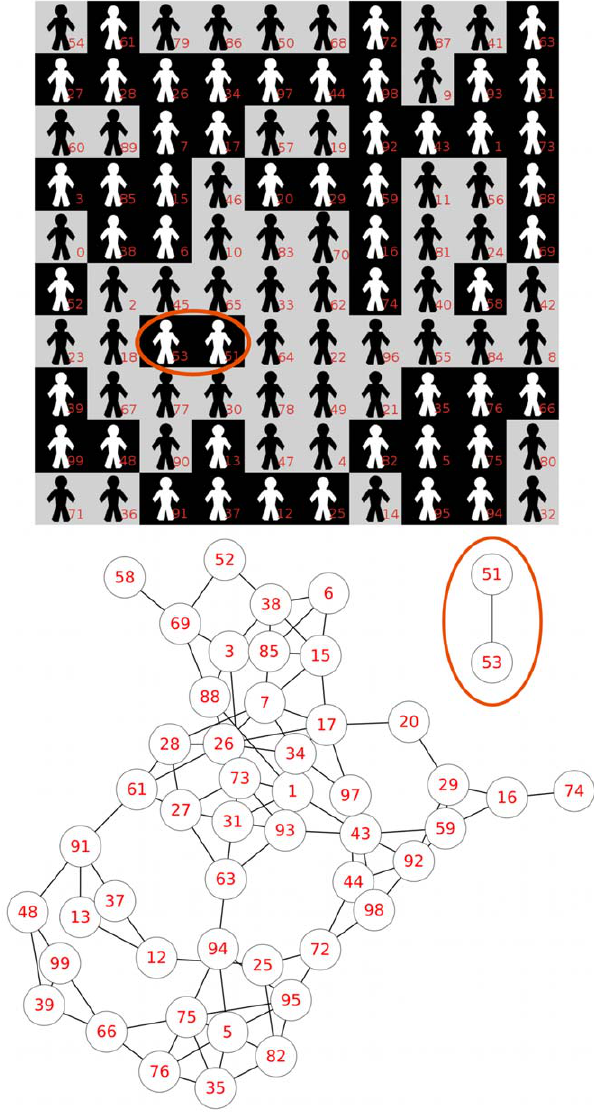
Figure 6. An example case that shows two disconnected groups in the white tag intratype interaction network. Upper figure: spatial distribution of agents with two disconnected groups within white-tagged agents. Lower figure: the corresponding white tag intratype interaction network in which the partition of the network is easily seen (the 51–53 couple vs the rest of white agents). Although it has not been mentioned, note that it is not difficult to identify two other disconnected groups within black agents in this example (the 60– 89 couple vs the rest of the black agents).